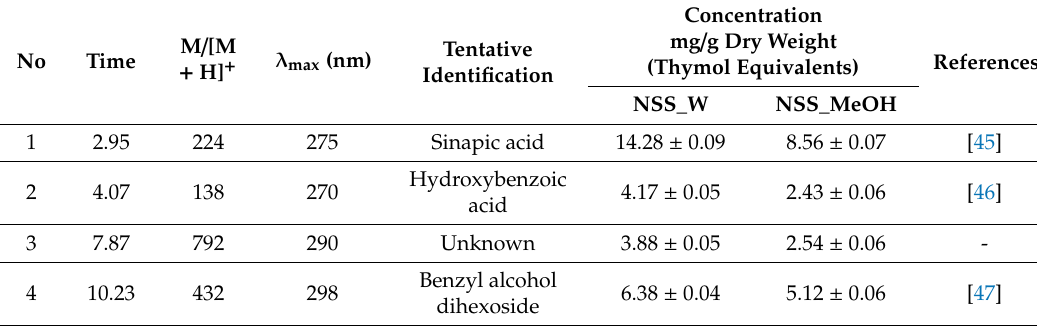
Table 2. Tentative identification, characterization and concentration of major compounds identified in Nigella sativa seeds water and methanolic extracts.